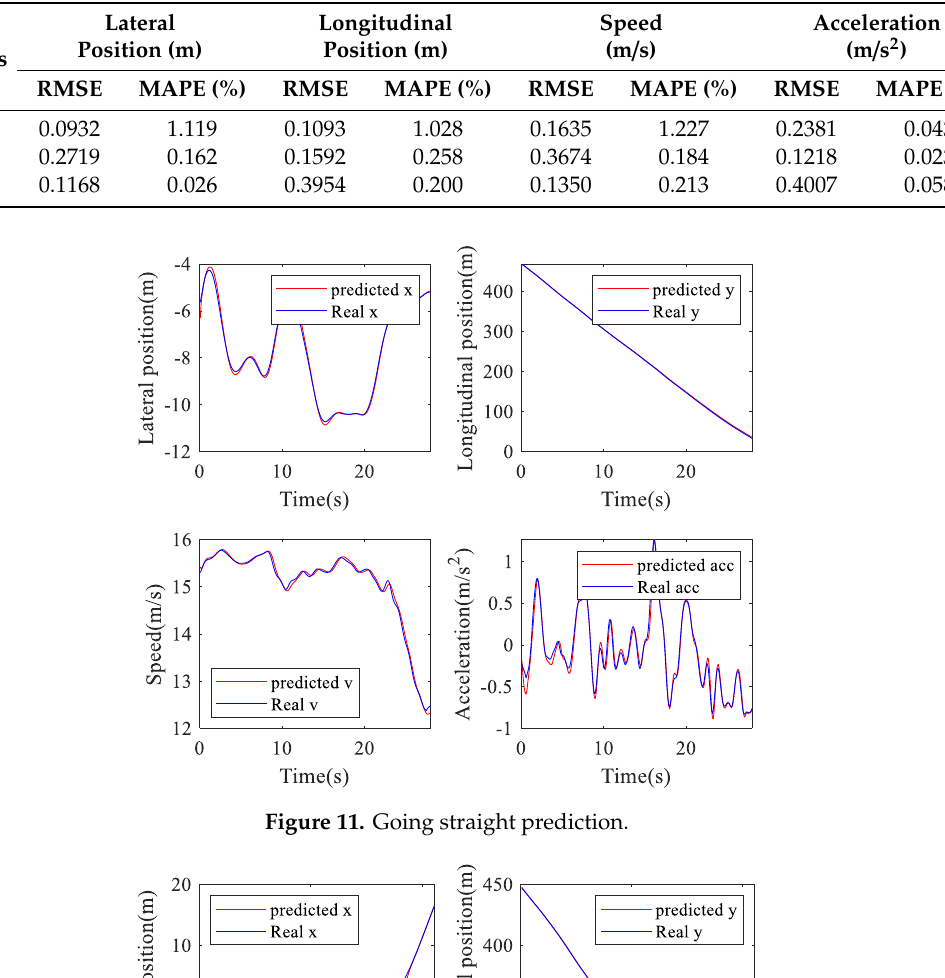
Table 2. The root mean square error (RMSE) for vehicle’s position, speed, and acceleration in straight through and turn scenarios.